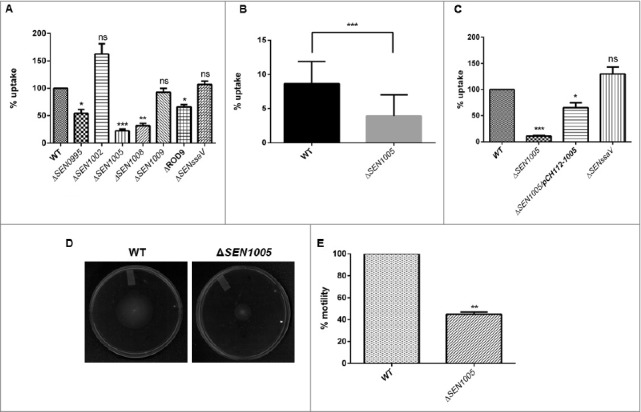
Bacterial uptake assay in murine macrophages RAW264.7 and analysis of motility. (A) % uptake of WT and its ROD9 mutants by murine macrophages RAW264.7 at 2h p.i.. (B) % uptake of GFP-expressing WT and ΔSEN1005 by RAW264.7 at a MOI of 50 bacteria/cell after 2h of infection by flow cytometry. (C) Uptake of WT, ΔSEN1005 and ΔSEN1005/pCH112-1005 by murine macrophages RAW264.7 at 2h p.i. that shows restoration of WT phenotype in the complemented strain. (D) Motility assay was performed with WT and ΔSEN1005 by placing 1µl log phase cultures of bacteria with same O.D at the middle of 0.3% LB agar plates. After 5h of growth, the diameter of growth region was measured. Scale in cm. (E) Bar diagram for % motility of Salmonella measured from diameters of the bacterial growth. Results were deduced from three independent experiments in triplicates and data represented as mean ± SD. ns, not significant (P>0.05); Statistical significance: *P < 0.05, **P < 0.01, ***P < 0.001 (Student's t-test).